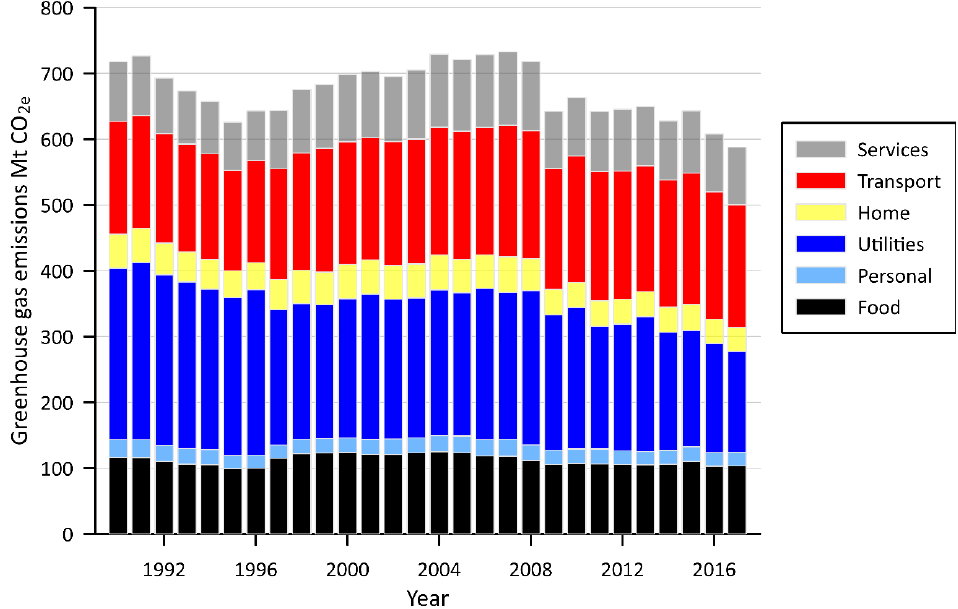
Figure 6. UK GHG emissions by sector over time, aggregated from emissions by product as described in Section 2.2 [42]. “Food” includes restaurants and hotels; “Personal” includes clothing, footwear, tobacco, alcohol, and other drinks; “Utilities” include fuel and water; “Home” includes rentals, repair, and furnishings; “Transport” includes personal transport and transport services; all other services are grouped into “Services” including medical, education, and recreation. Table 6. Comparison of GHG footprints (per person per year) calculated here using different meth- ods focused on the UK and the US.